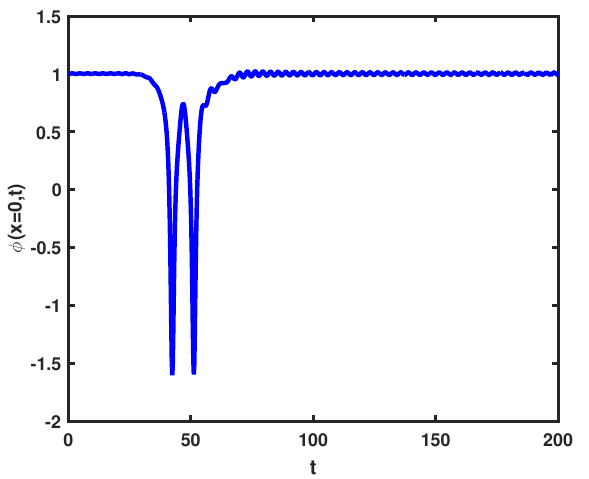
Figure 4 . False vacuum in an unbounded interval: kink-antikink collision showing a zero order ( m = 0) two-bounce for (cid:15) = 0 : 01 with v = 0 : 558. where X is the translational collective coordinate. The total energy of the kink-antikink sys- tem for large values of X is given by [82] E is the classical kink mass and (cid:1) (cid:26) = (cid:15)M 4 =(cid:21) is the energy density di(cid:11)erence between